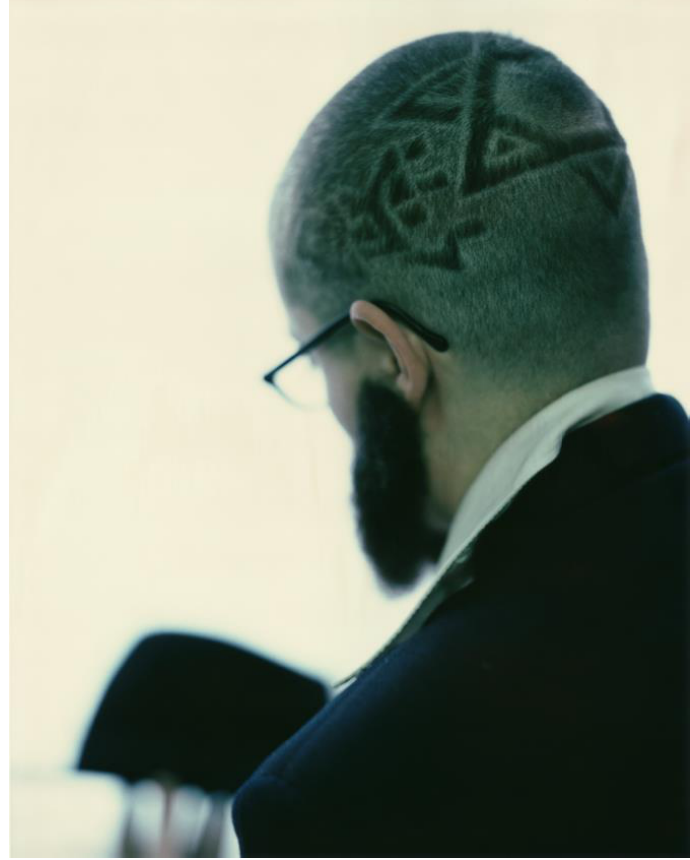
Figure 13. Oreet Ashery, Self Portrait as Marcus Fisher V , 2000, original 25.4 × 20 cm; Polaroid scanned to lambda prints, 100 × 110 cm. Photograph by Manuel Vason. Courtesy of the artist.